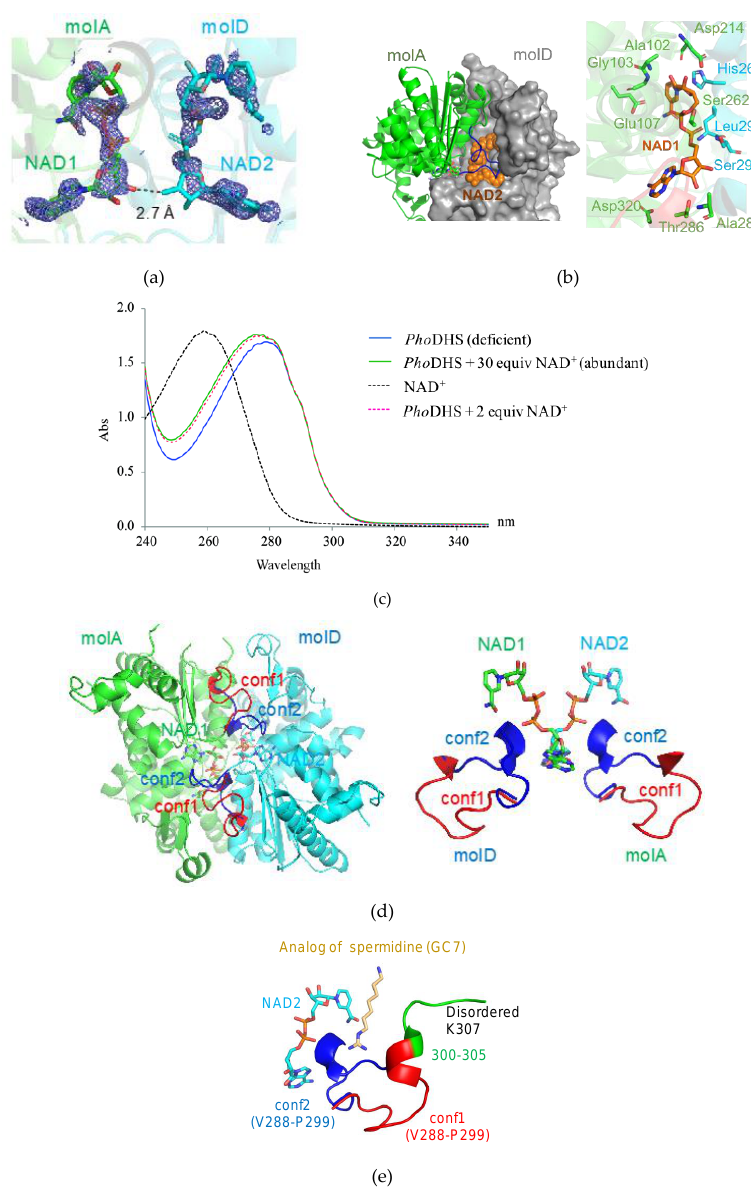
Figure 3. Active site of Pho DHS-bound NAD + . ( a ) Electron density map for NAD + . NAD + is superposed with the 2Fo-Fc electron density map contoured at the 1 σ level (blue). ( b ) Binding geometry of NAD + by Pho DHS. (left) NAD + is bounded to the interface of the dimer in a sandwich manner. (right) NAD + extensively interacts with residues from both monomers via a hydrogen bond and electronic interaction. ( c ) Quantification of NAD + bound to Pho DHS in solution by UV absorbance spectroscopy. An obvious di ff erence in the absorption curves for Pho DHS alone (no NAD + added) and supplemented with NAD + as Pho DHS + 30 equiv NAD + (molar ratio Pho DHS:NAD of 1:30), shows the binding of NAD + to vacant sites in purified Pho DHS. The absorption curve of Pho DHS + two equiv NAD + (molar ratio 1:2) correlates well to the curve Pho DHS + 30 equiv NAD + , indicating that Pho DHS could only accommodate two additional NAD + even if excessive NAD + molecules are available. ( d ) (left) Closed (blue) and open (red) forms of the binding loop V288–P299 with NAD + bound. (right) Alternative conformations of the loop involved in NAD + and spermidine binding. ( e ) Superposition of GC7 onto Pho DHS. GC7 is superposed onto Pho DHS by structural alignment with human DHS in complex with GC7. The loop of two conformations (conf1 and conf2) in molA and molD was generated by the superposition of the two